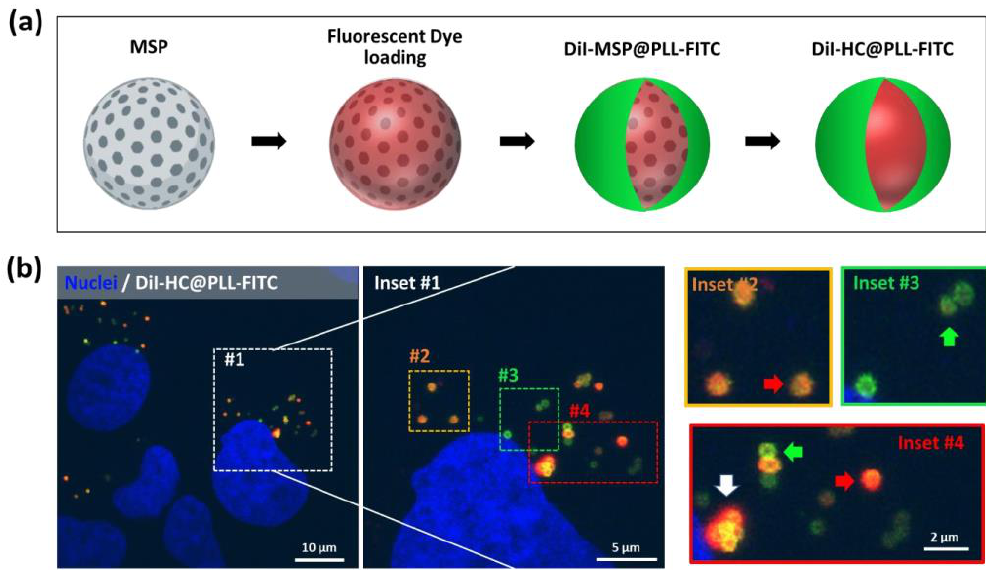
Figure 4. ( a ) Scheme of fluorescent PEE-DiI filled capsule design. MSPs are loaded with DiI and coated with a fluorescent PEE, in this case, fluorescein isothiocyanate (FITC) poly-L lysine (PLL-FITC). ( b ) Single plane confocal images of Hela cells treated with DiI filled PEE capsules (DiI-HC@PLL-FITC) for 96 h. ( inset #1 ) Magnification of the area allows the identification of individual intracellular capsules and their contents. ( inset #2 ) Filled particles loaded with DiI (orange). ( inset #3 ) FITC empty fluorescent capsules (green). ( inset #4 ) Capsules releasing DiI (white arrow) intermingle with empty capsules (green arrows) and filled intact capsules (red arrow) within the cellular cytoplasm. Cell nuclei are stained with Hoechst (blue channel).